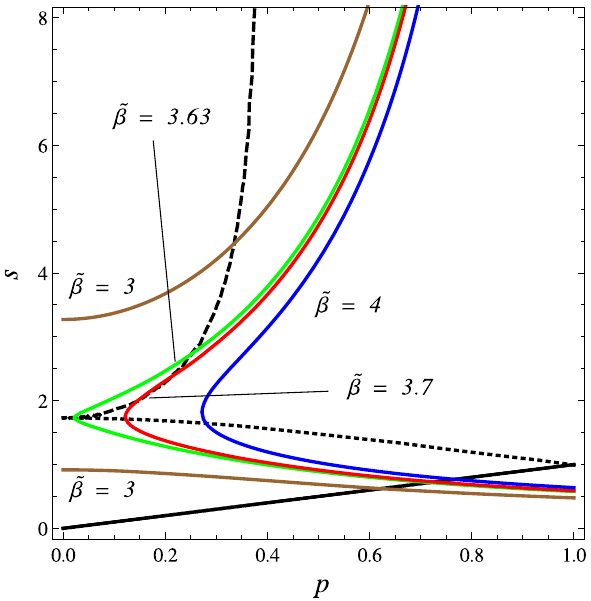
Fig. 20 Plots of β = const. curves on the ( p , s ) space for ˜ β = 3 (brown), ˜ β = 3 . 63 (green), ˜ β = 3 . 7 (red) and ˜ β = 4 (blue)